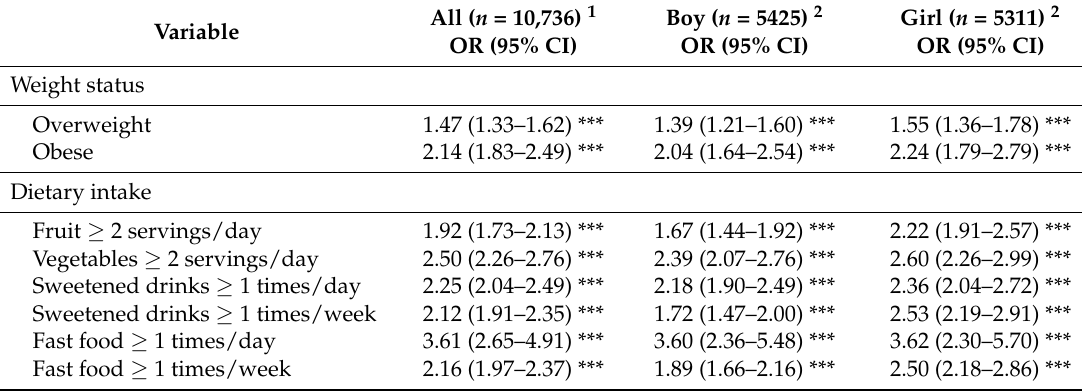
Table 2. Logistic regression associations between poverty and weight status and poverty and dietary intake among adolescent girls and boys.